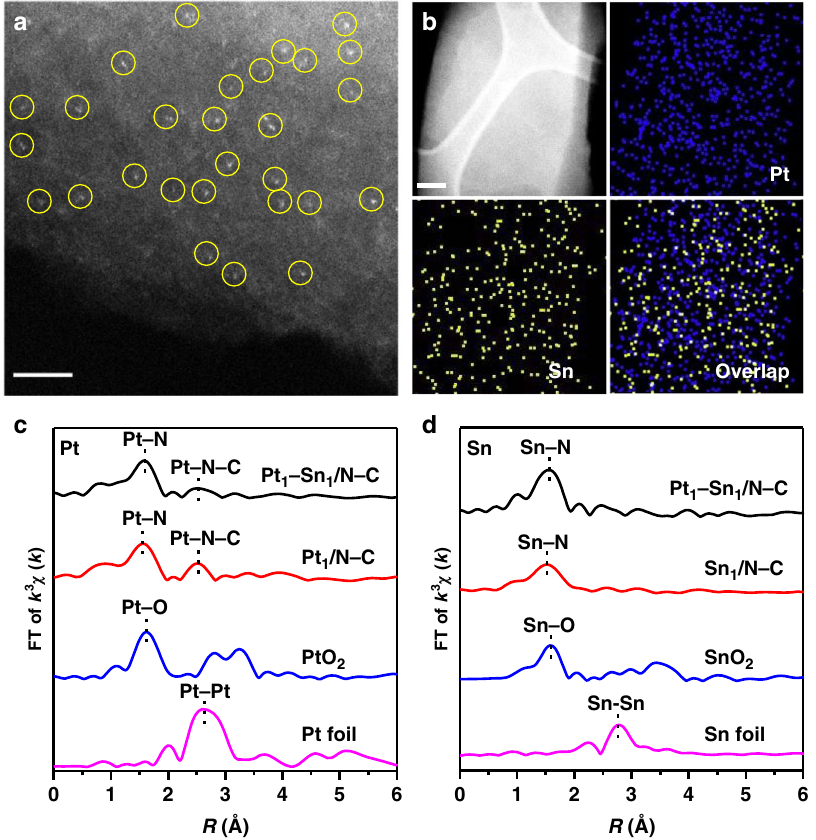
Fig. 4 Structural characterization of Pt 1 – Sn 1 /N – C. a AC HAADF-STEM image of Pt 1 – Sn 1 /N – C. SAs were highlighted by yellow circles. Scale bar, 2 nm. b element mapping of Pt 1 – Sn 1 /N – C. Scale bar, 100 nm. c The Pt k 3 -weighted R-space FT spectra of EXAFS for Pt 1 – Sn 1 /N – C, Pt 1 /N – C, PtO 2 , and Pt foil. d The Sn k 2 -weighted R-space FT spectra of EXAFS for Pt 1 – Sn 1 /N – C, Sn 1 /N – C, SnO 2 , and Sn